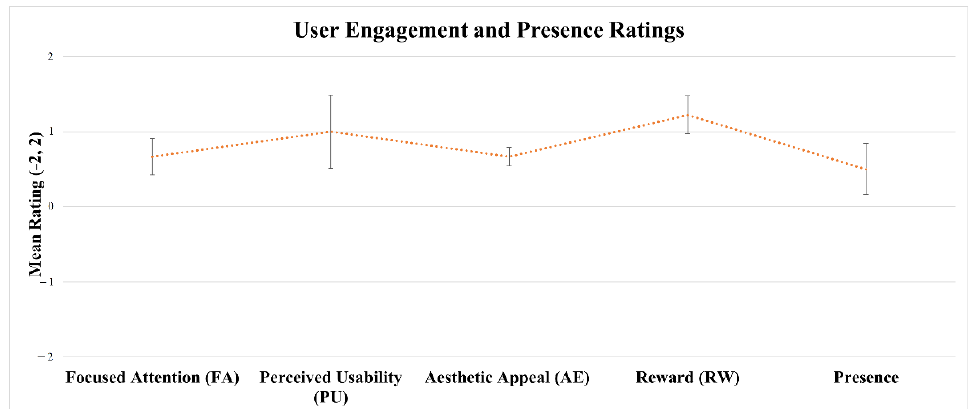
Figure 4. Mean rating and standard error of user engagement and presence scales, collapsing over six participants. FA, PU, AE, and RW represent factors from user engagement’s UES [43], followed by a measure of presence [37]. These self-reported ratings identified factors from the user’s overall experience with the software and served as discussion points for an exit interview. Responses trended toward the positive, with neutral-to-negative ratings investigated further during the exit interview.